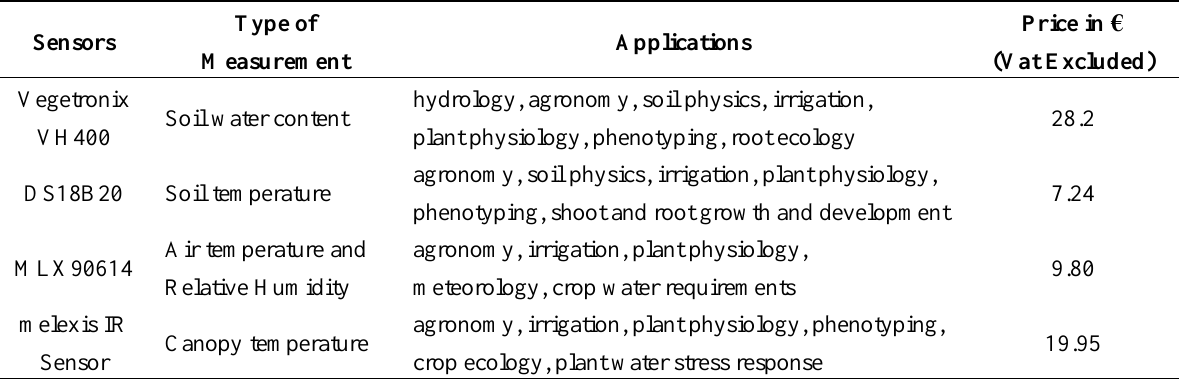
Table 2. Prices for each sensor (source [53,54]), type of measurement and possible